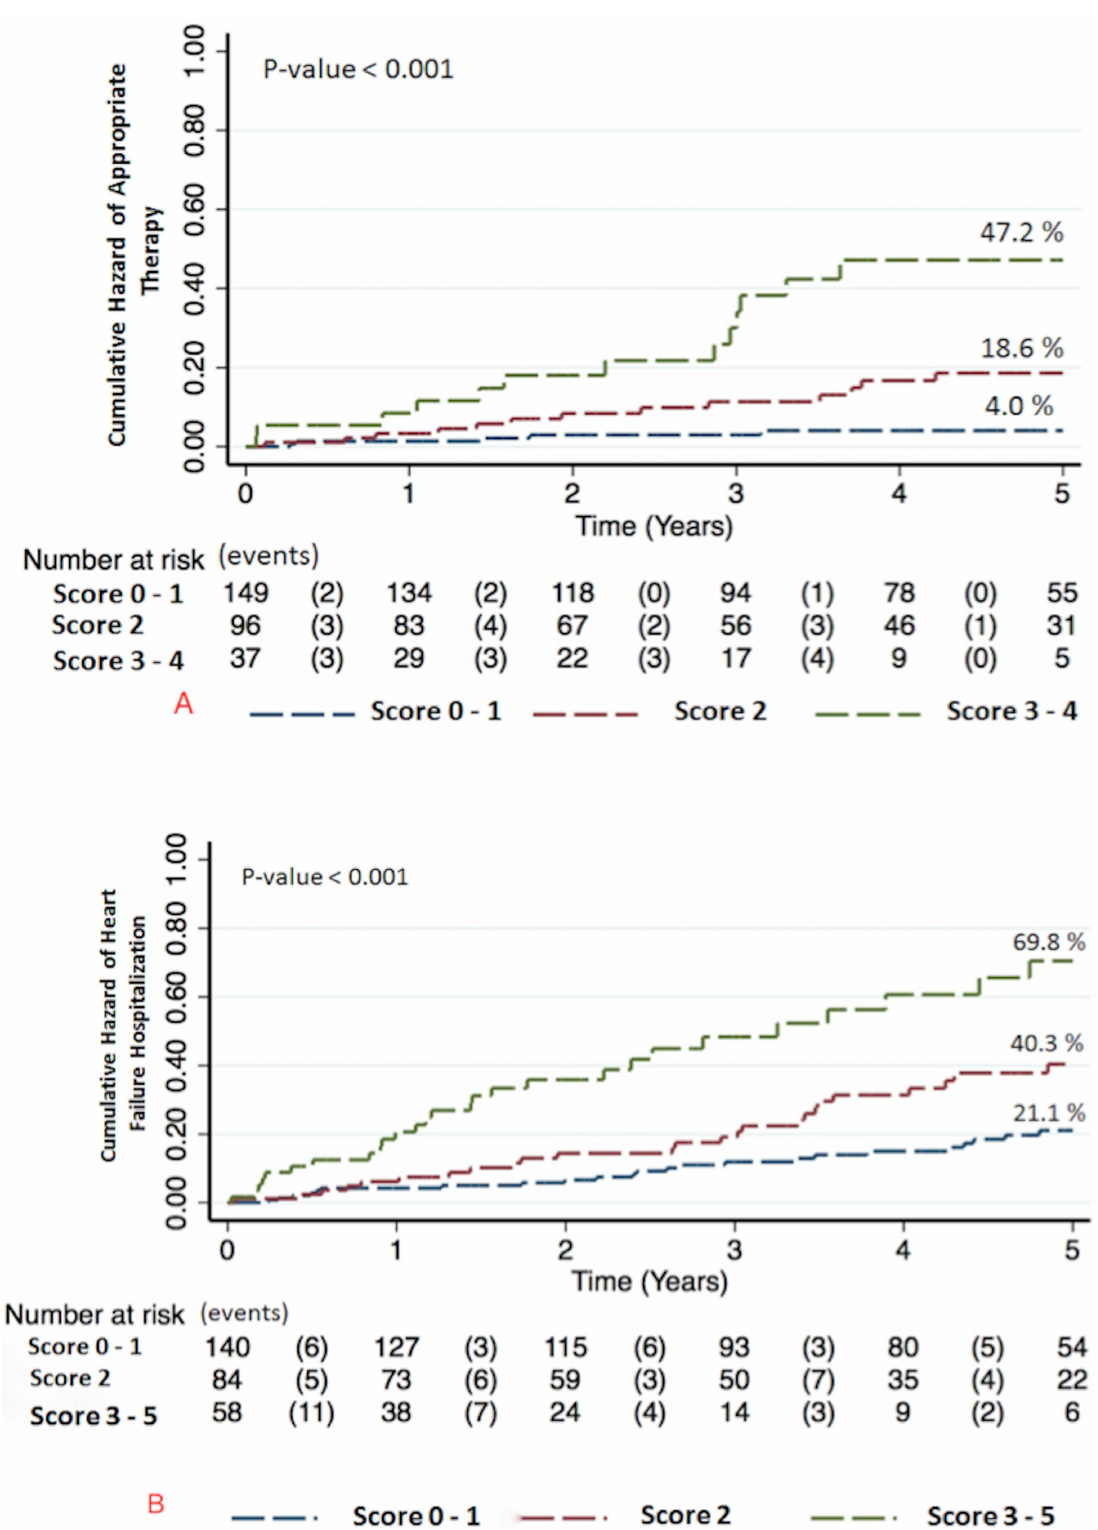
Fig 2. Cumulative hazard according to score categories. (A) Cumulative hazard of appropriate therapy accordingto score categories. (B) Cumulativehazardof HF hospitalization accordingto score categories.